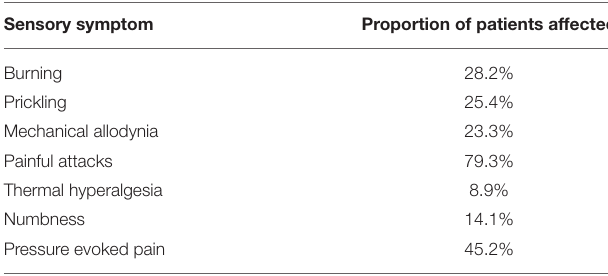
TABLE 3 | Correlations between painDETECT score and cognitive-affective variables.